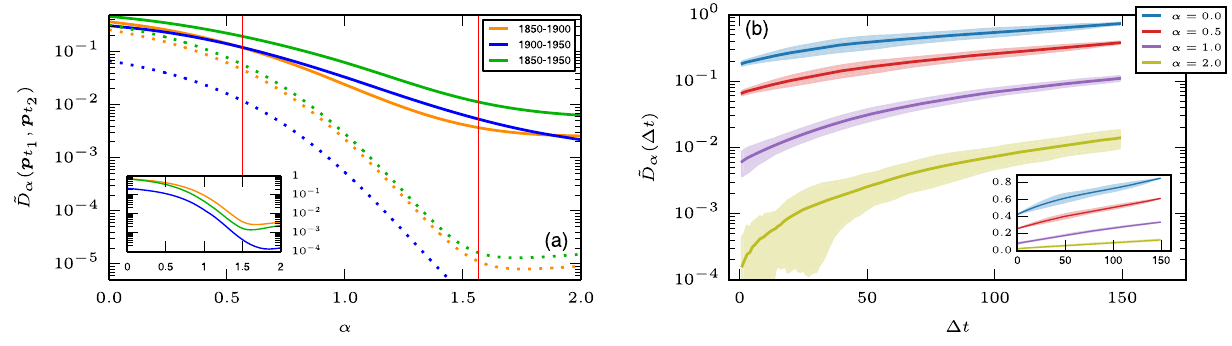
~ D p ; p α for pairs of α ð t 1 t 2 Þ as a function of ~ D p ; p N (see Sec. IV), obtained using α ð t 1 t 2 Þ with ~ D Δ t ≡ j t − t Δ t Þ ¼ 2 1 j , calculated as α ð